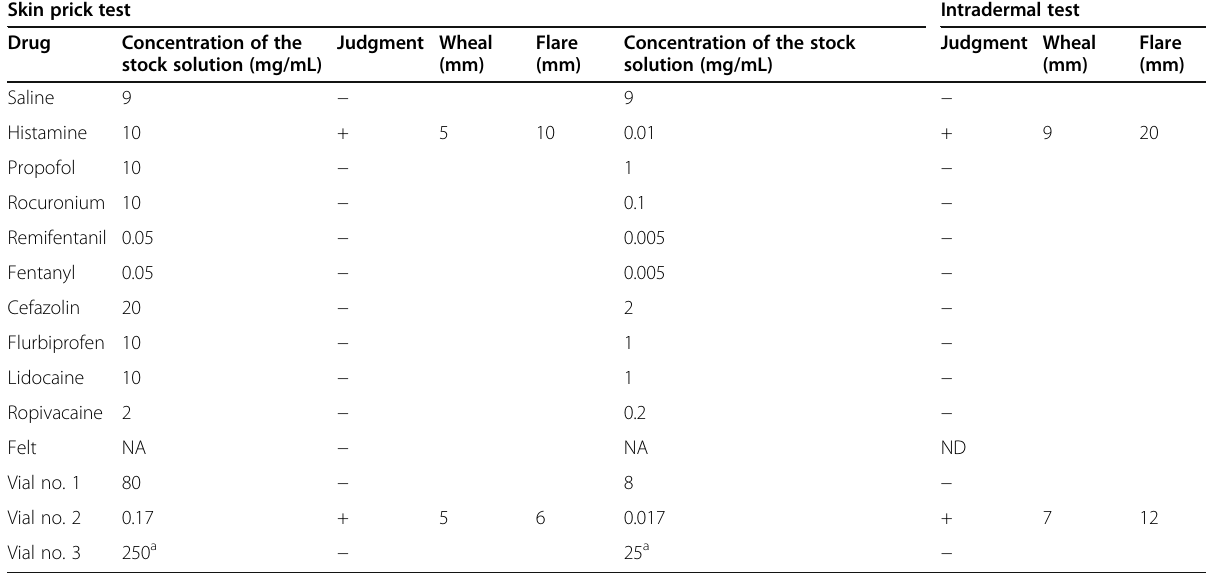
Table 1 Results of skin tests Skin prick test Intradermal